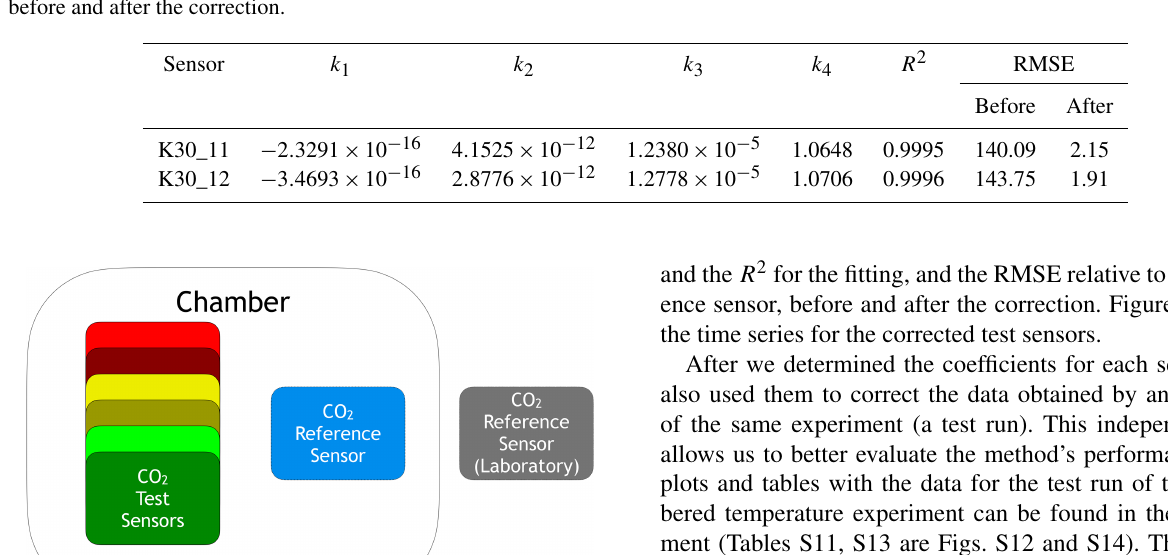
Table 1. Coefficients from the pressure correction method and root mean square errors for the test sensors relative to the reference sensor, before and after the correction.